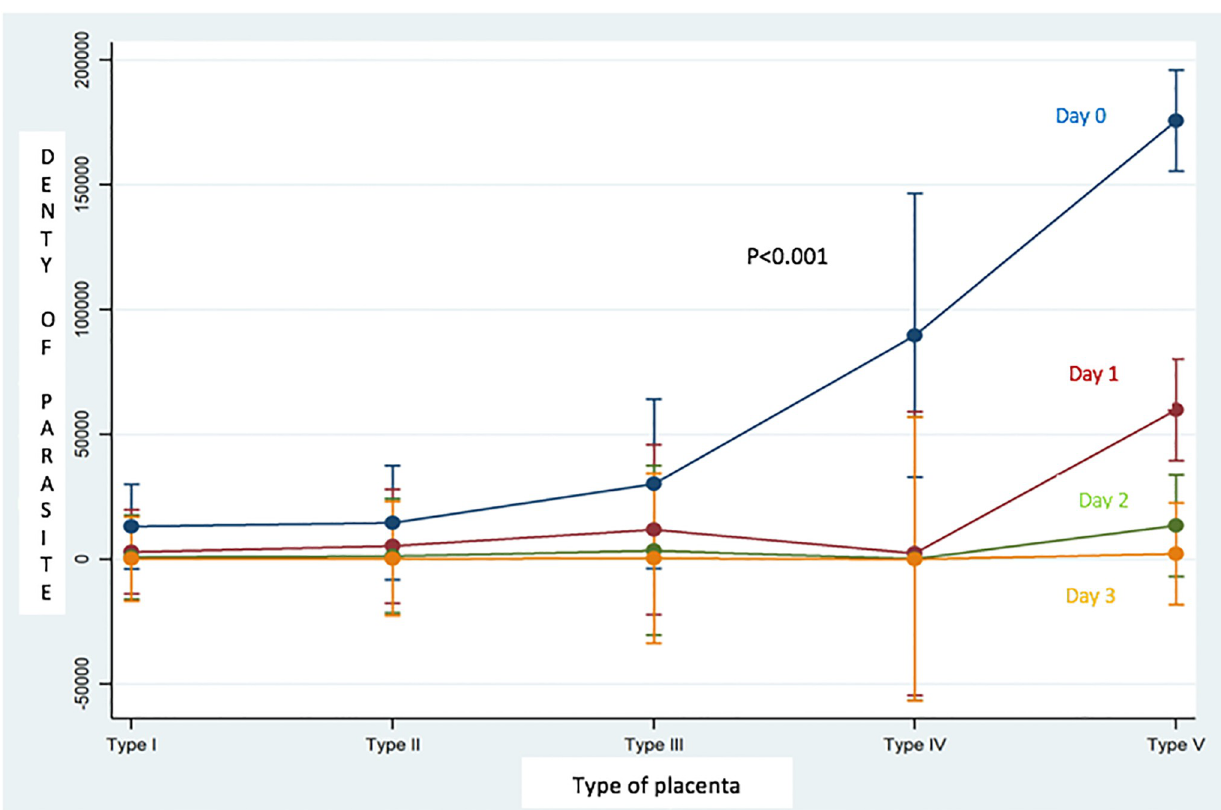
Fig 3. Correlation between parasite density and type of placental